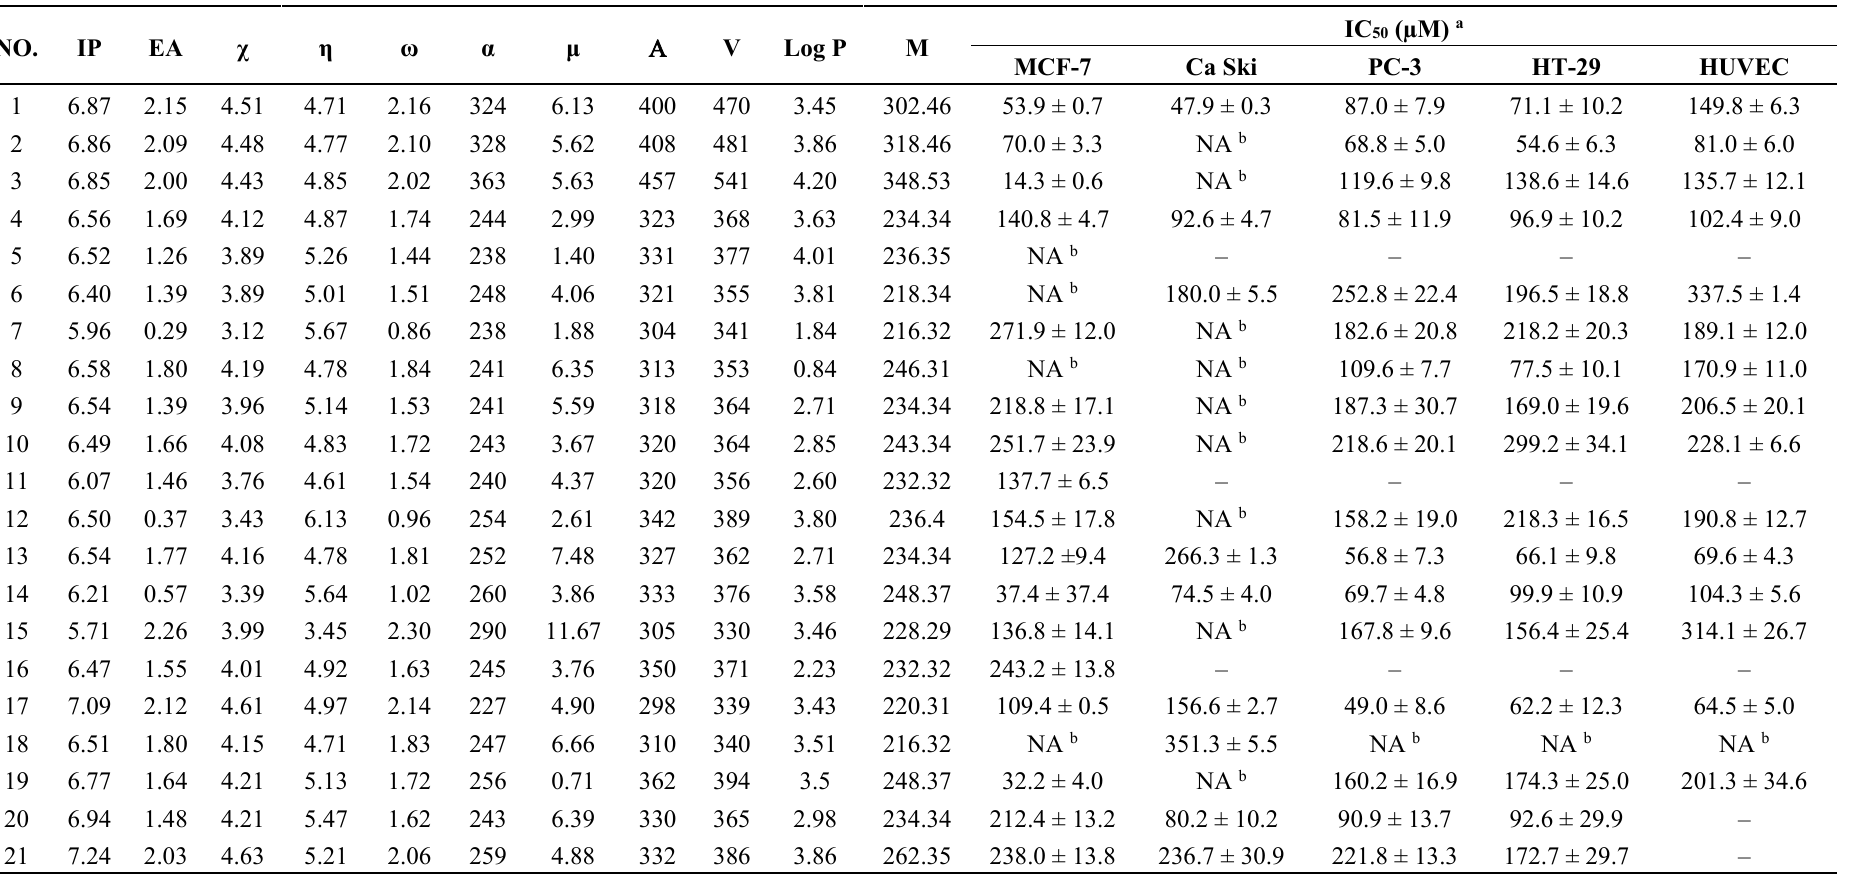
Table 1. Cytotoxicity IC 50 (µM) and molecular descriptors obtained at B3P86/6-311+G (d, p) level for the isolated